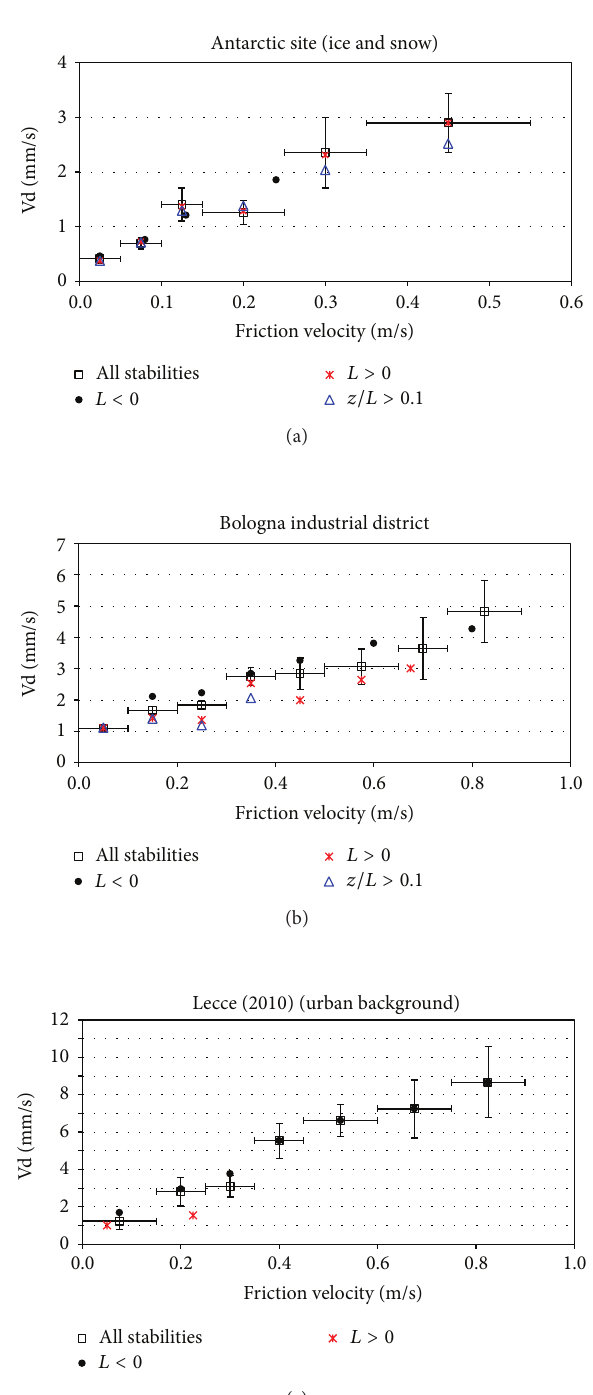
Figure 3: Functional dependence of deposition velocity (Vd) from friction velocity ( 𝑢 ∗ ) for different measurement datasets (as reported in the title of each graph) for particle number concentration (PNC). Error bars represent standard